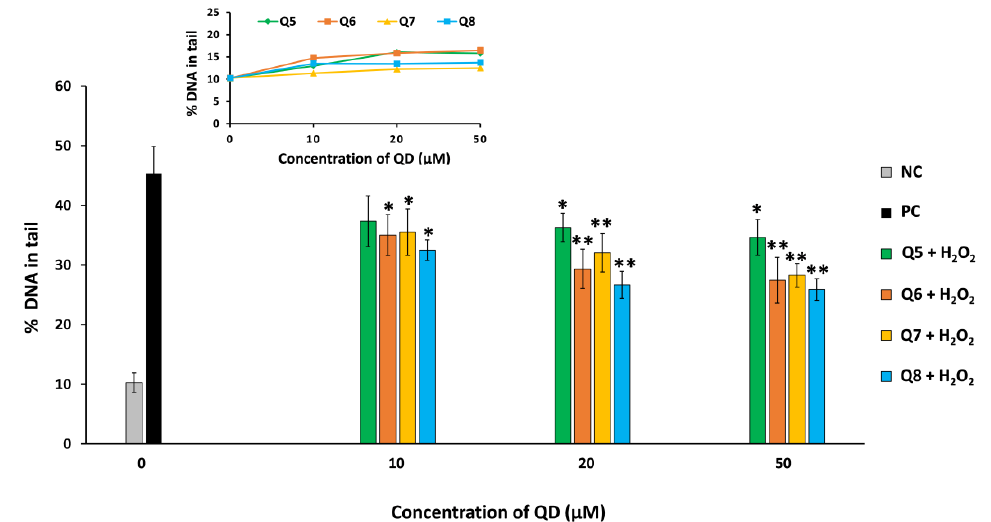
Figure 4. DNA-protective effect of derivatives Q5–Q8 against H 2 O 2 measured by comet assay. TH-1 cells were pre-treated with quinazolinone derivatives (QDs) for 24 h and then treated with 500 µ M H 2 O 2 (coloured columns). TH-1 cells only with phosphate-buffered saline (PBS) were used as negative control (NC) (grey column); cells incubated only with 500 µ M H 2 O 2 correspond to a positive control (PC) (black column). The inserted panel represents the incidence of DNA damage in TH-1 cells treated with derivatives Q5–Q8 tested individually. Data represent the mean ± SD of three independent experiments. * p < 0.05; ** p < 0.01refers to significant difference to positive control.